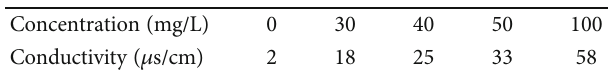
Figure 4: Electrosorption curves for the synthesized UiO-66 materials, for di ff erent NaH (hydrochloric acid)). Table 1: Conductivity of the sodium dihydrogen phosphate solution, at di ff erent concentrations, at 25 °